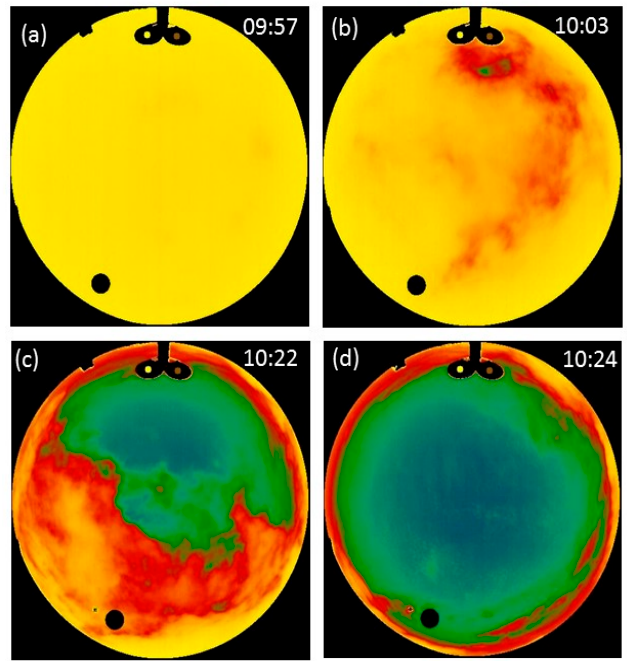
Figure 8. Sky image on 6 January 2021. ( a ) 09:57—Fully developed dense fog. ( b ) 10:03—the fog begins to dissipate. Low-density patches are clearly visible. ( c ) 10:22—Snapshot in the middle of the rapid clearing process. Half of the sky is clear. ( d ) 10:24—the sky is almost completely clear. Some residual fog patches are still present close to the